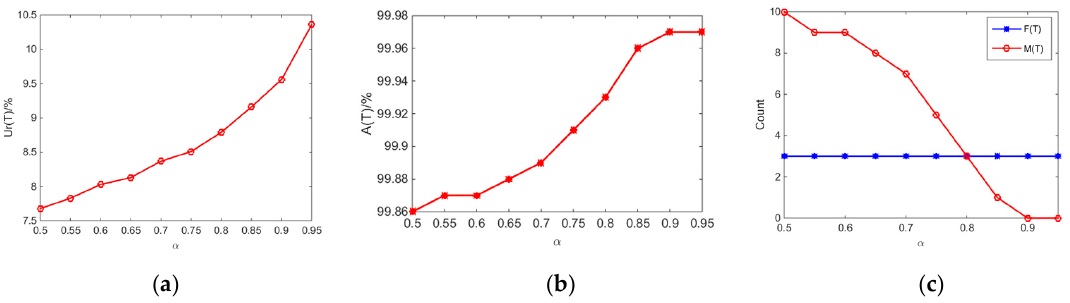
Figure 6. Impact of α on classification results ( β = 0.05 ): ( a ) rate of uncertain instances U r ( T ) ; ( b ) accumulative accuracy A ( T ) ; ( c ) count of F ( T ) and M ( T ) .